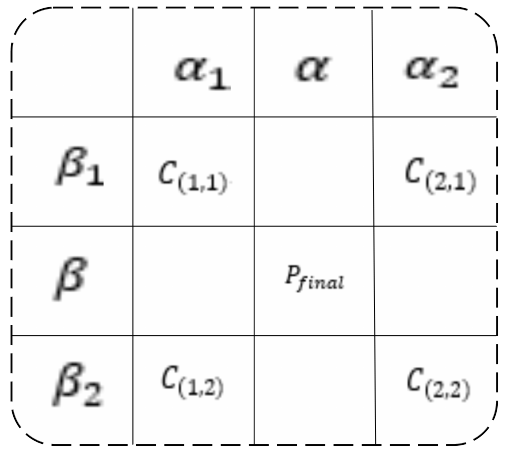
Figure 2. Bilinear interpolation method to find the final point ( P_final) for the newly interpo- lated